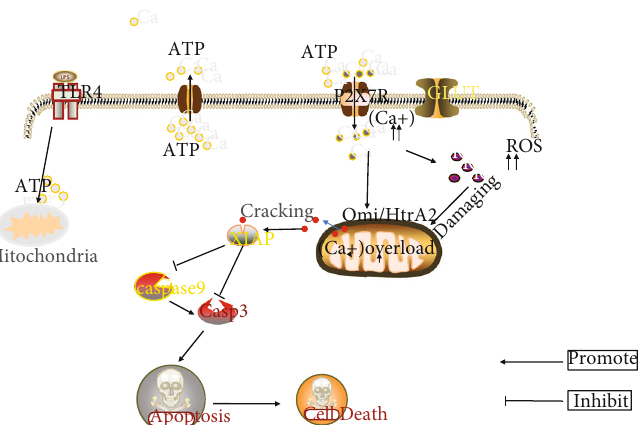
Figure 6: LPS stimulated cells to induce the P2X7R-mediated intracellular Omi/HtrA2 apoptosis signaling pathway. Under the stress stimulation of LPS, mitochondria in cells will produce a large amount of ATP and activate P2X7R on the cell surface. The activated P2X7R will cause a large amount of Ca2+ in fl ux, and then the imbalance of intracellular Ca2+ homeostasis will lead to the production of a large amount of intracellular ROS and further cause mitochondrial damage. However, Ca2+ overload in mitochondria will further increase the production of ROS and cause the transfer of OMI/HtrA2 in the damaged mitochondrial membrane space into the cytoplasm. Omi/HtrA2 in the cytoplasm can crack the apoptosis inhibiting protein XIAP, which leads to the decrease of XIAP inhibiting caspase-3 and caspase-9 in cells, and promotes cell